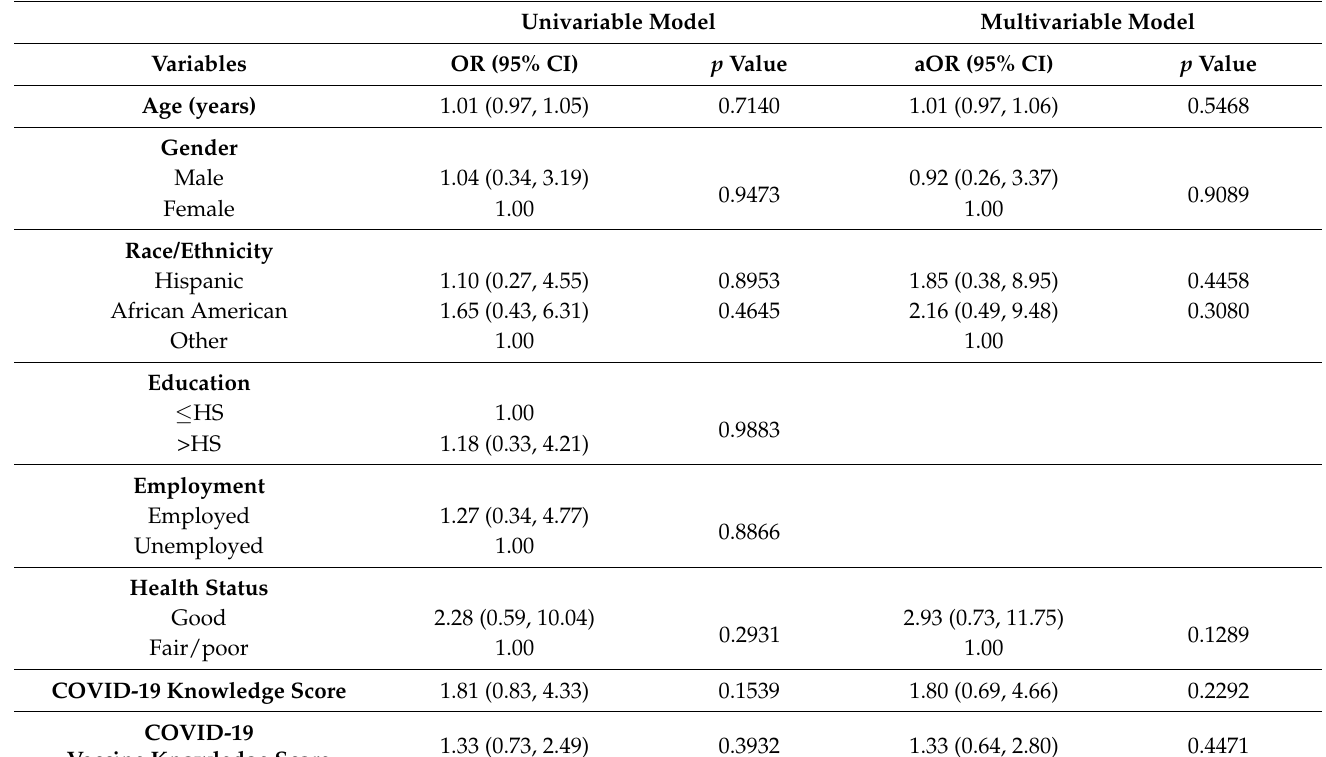
Table 2. Univariable and multivariable logistic regression models at survey time and 6 months post-survey on vaccine status. Logistic Regression Model for Vaccine Status at Survey (21 vs. 31) Univariable Model Multivariable